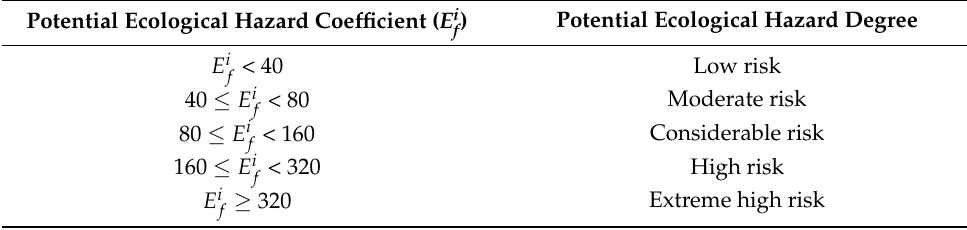
Table 1. Hankanson’s potential ecological hazard assessment index